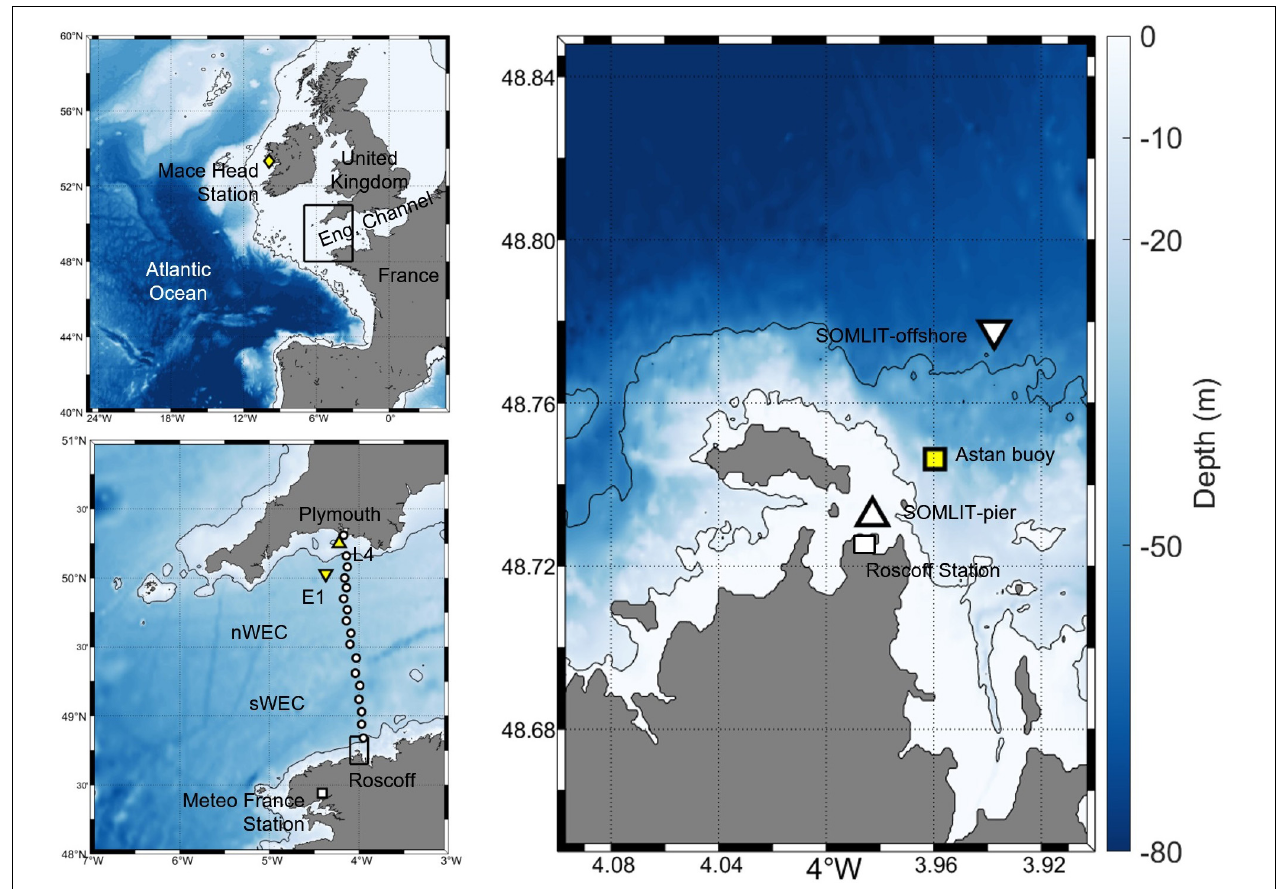
FIGURE 1 | (Right) Map and bathymetry (5 and 50 m isobaths) of the study area in the sWEC with the location of the ASTAN buoy (yellow square) with the two SOMLIT sampling sites: SOMLIT-pier (upward triangle) and SOMLIT-offshore (downward triangle) and the location of the Roscoff observatory. (Top left) Map and bathymetry (200 m isobath) of the North Atlantic Ocean with the location of the Mace Head atmospheric station, the black frame represents the WEC. (Bottom left) Map and bathymetry (50 m isobath) of the WEC with the Meteo France station (white square) for wind speed data, E1 (downward triangle), L4 (upward triangle) and FerryBox transect from Roscoff to Plymouth used in the comparison of FCO 2 in Section “Dynamics of FCO 2 in the WEC” and Figure 10